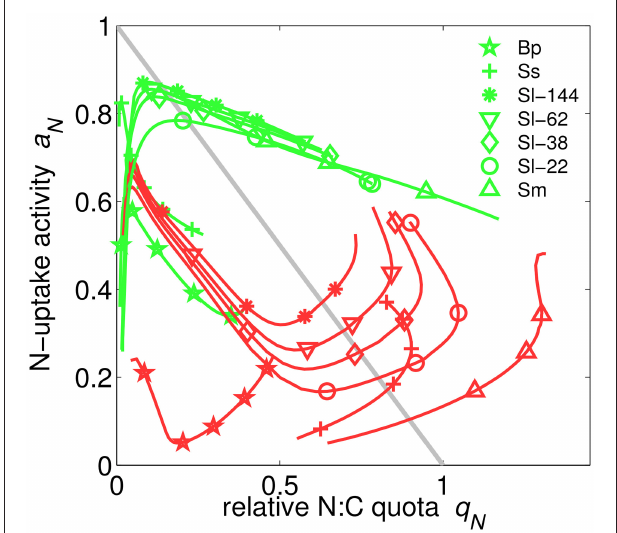
FIGURE 5 | Nitrogen uptake activity a N over relative N-quota q N in N- (green) or P-limited (red) cultures simulated for different chemostat conditions and species ( Sm, S. minutum ; Sl, S. linearis ; Ma, M. aeruginosa ; Ss, Scenedesmus sp.; Tp, T. pseudonana ; Bp, B. pendula ). Results for the one experiment using three instead of two nutrients (Tp) are omitted here. For comparison, the simple linear relationship a N = 1 − q N is plotted as gray